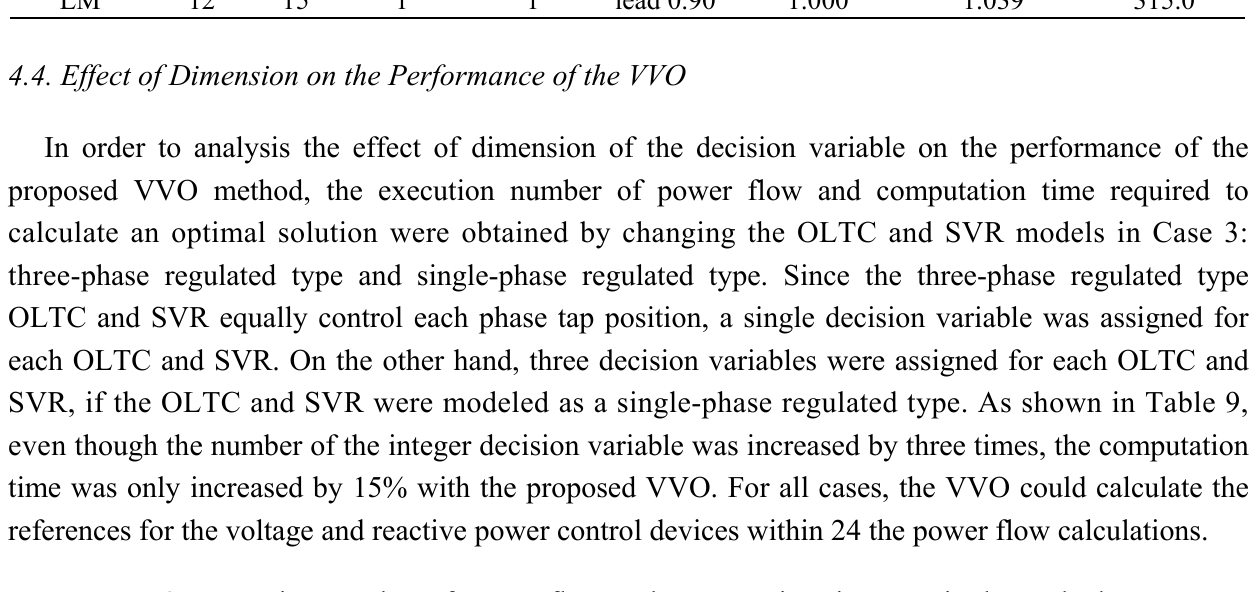
Table 9. Execution number of power flow and computation time required to calculate an optimal solution (TPR: three-phase regulated type; and SPR: single-phase regulated